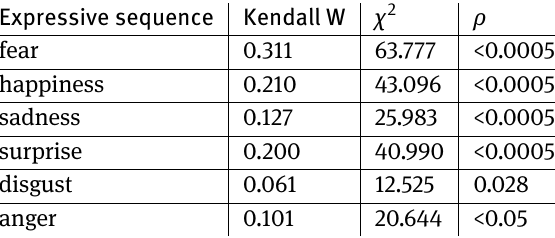
Table 6: Kendall W related scores for the six sequences. All Se- quences have df = 5